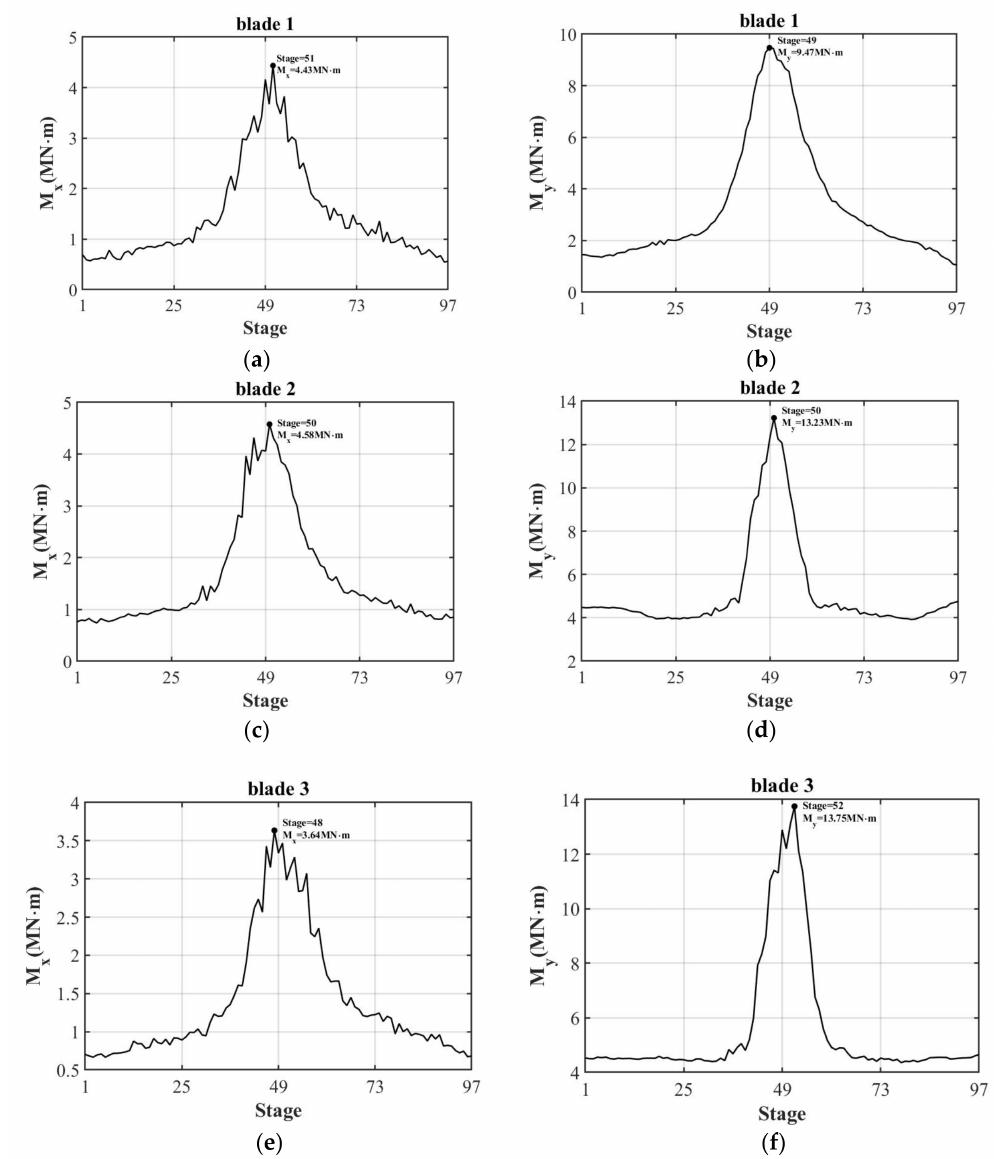
Figure 17. Maximum edgewise moment and flapwise moment at the blade root at different stages: ( a , b ) Blade 1, ( c , d ) Blade 2, and ( e , f ) Blade